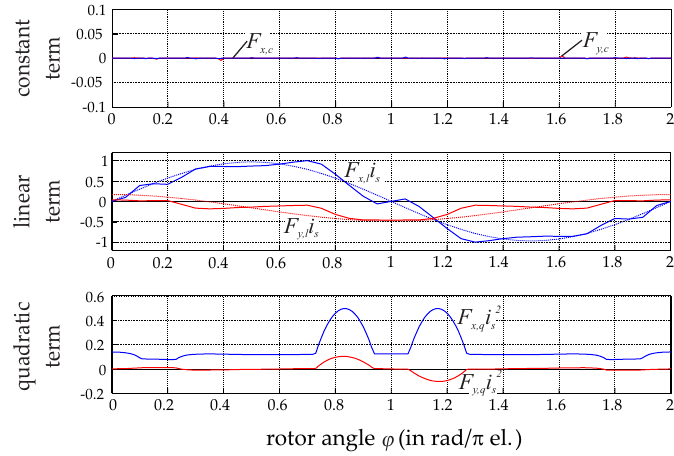
Figure 5. Analytically computed and separated suspension force components; all curves were normalized with the maximum of F x,l ( φ ) i s